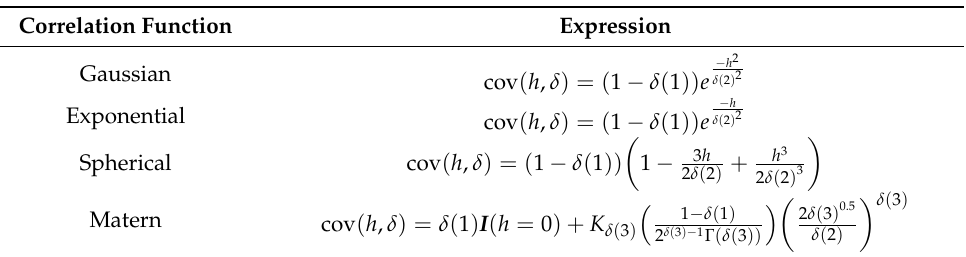
Table 1. Expressions for correlation